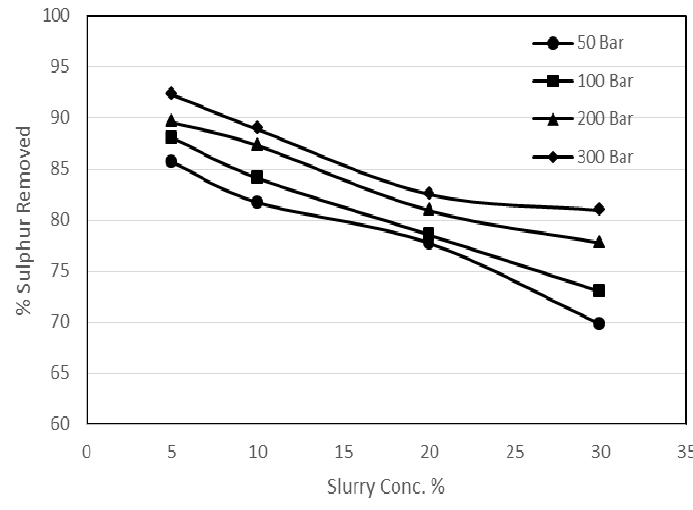
Figure 7. Effect of coal slurry concentration on pyritic sulphur removal.